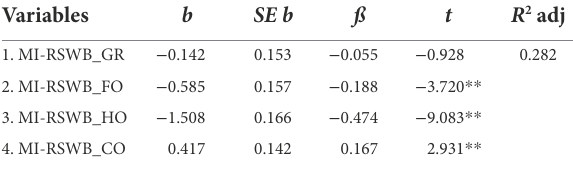
TABLE 2 Regression model: BSI-GSI Score as dependent variable predicted by the four subscales of religious/spiritual well-being. Variables b SE b ß t R 2